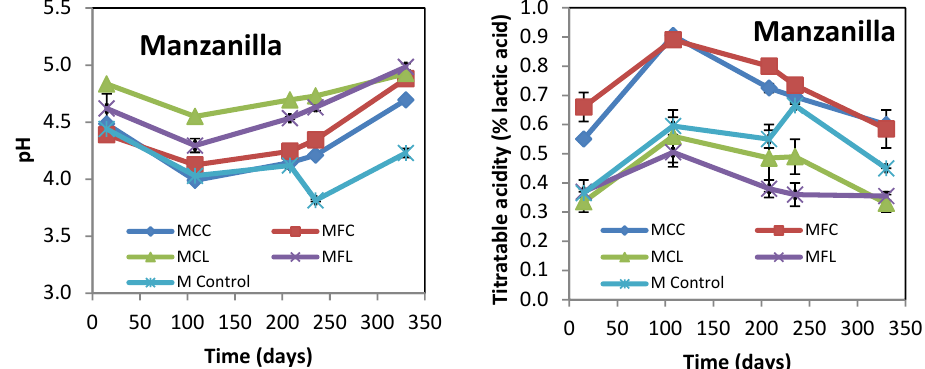
Figure 1. The changes in the pH and titratable acidity of Gordal and Manzanilla samples during fermentation. The points are the means of duplicate fermentations. Error bars show the range of the data (n = 2). Where error bars are not visible, the values were within the range of the symbols. See Table 5 for the meanings of samples abbreviations.